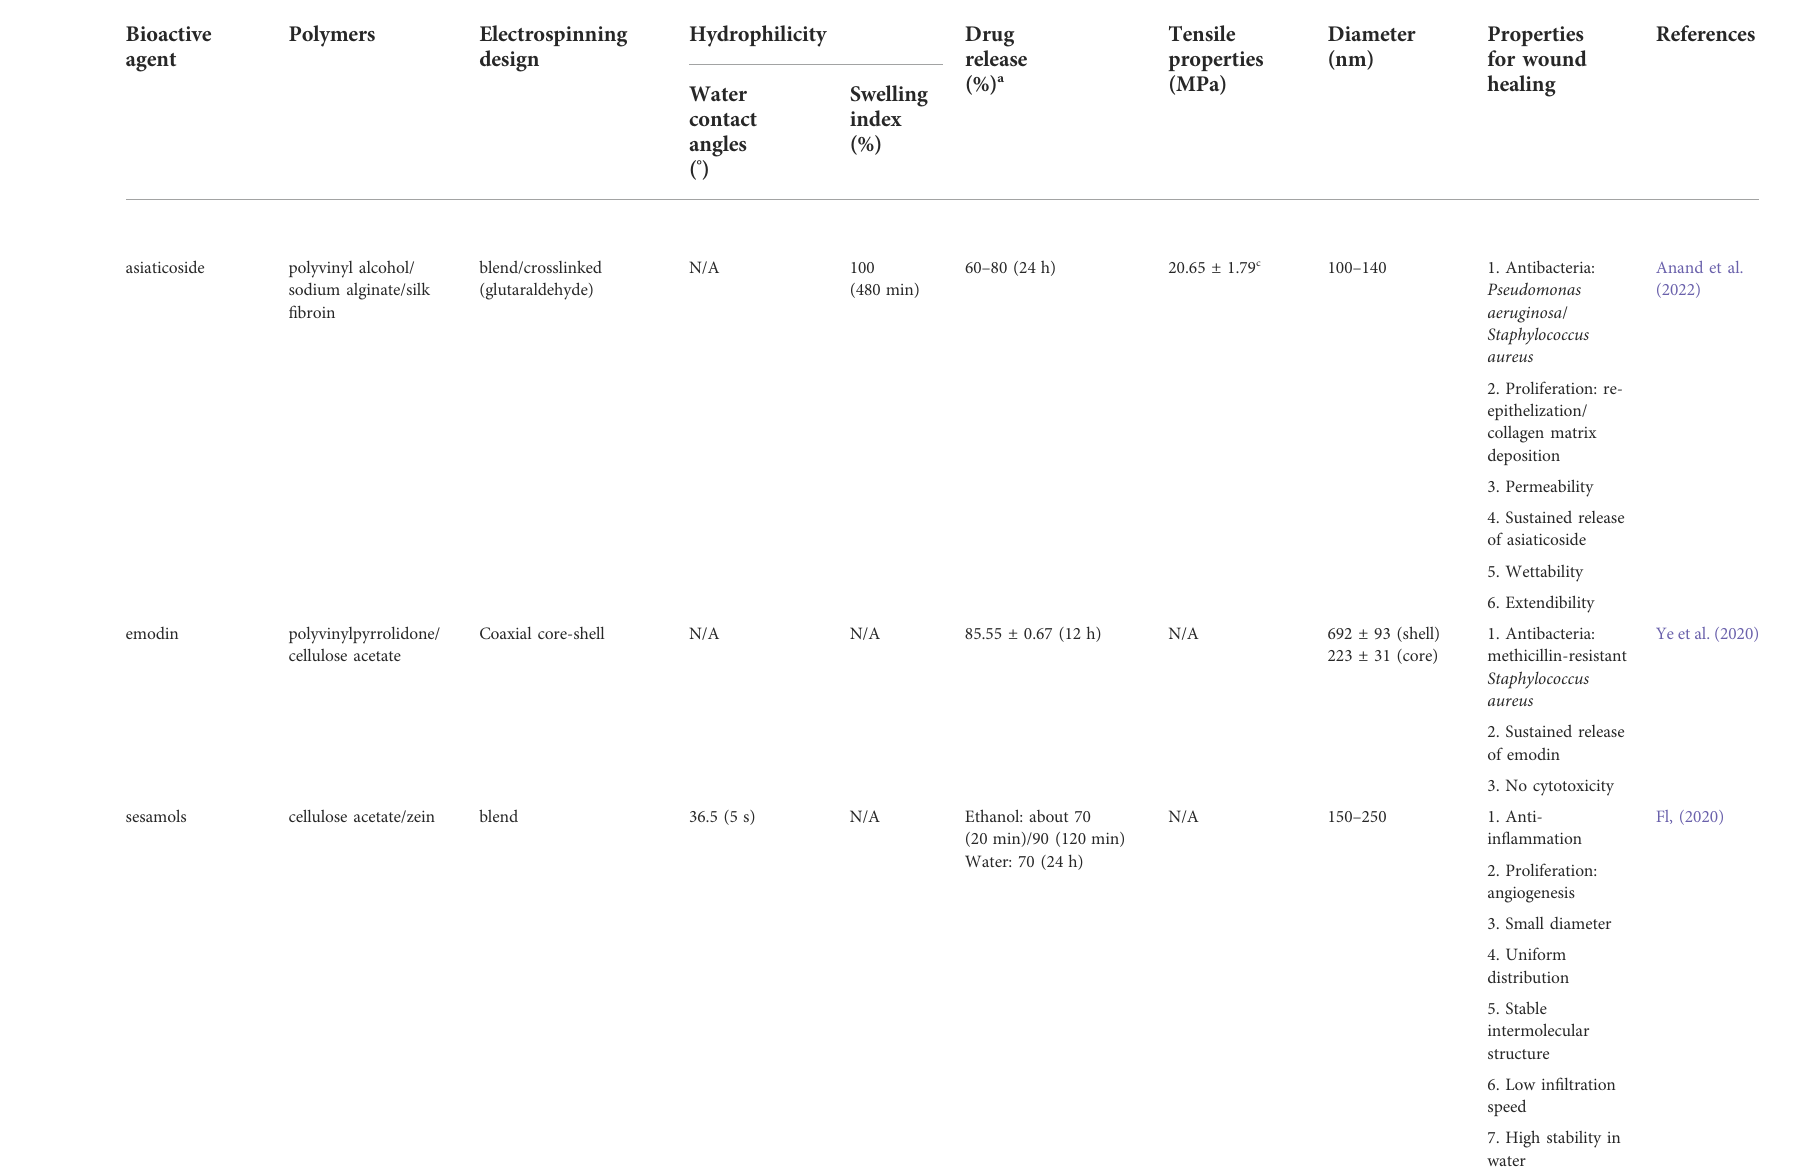
TABLE 1 ( Continued ) Botanicals as loaded-drugs used in electrospinning for wound